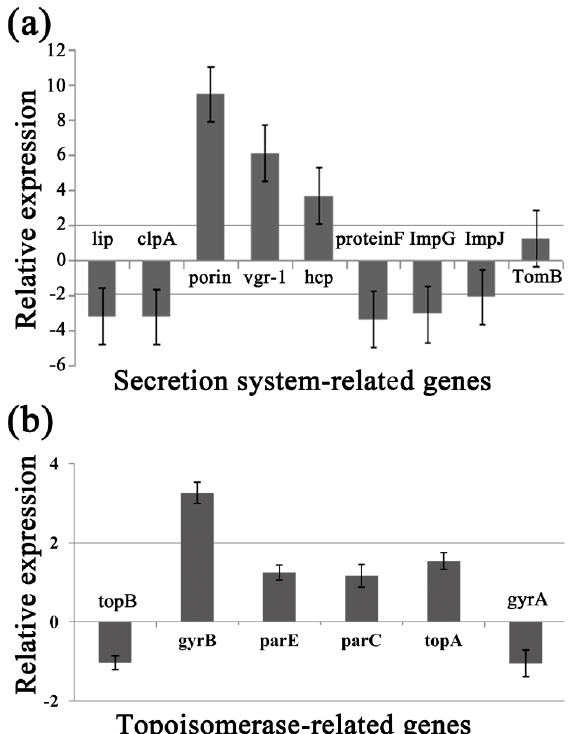
Figure 9. Effect of CPT at 0.5 mg/mL on the expression of secretion system- or topoisomerase-related genes of Acidovorax avenae subsp. avenae strain RS-2. ( a ) Secretion system-related genes; ( b ) Topoisomerase-related genes. Data are the average value of three replicates with standard error.